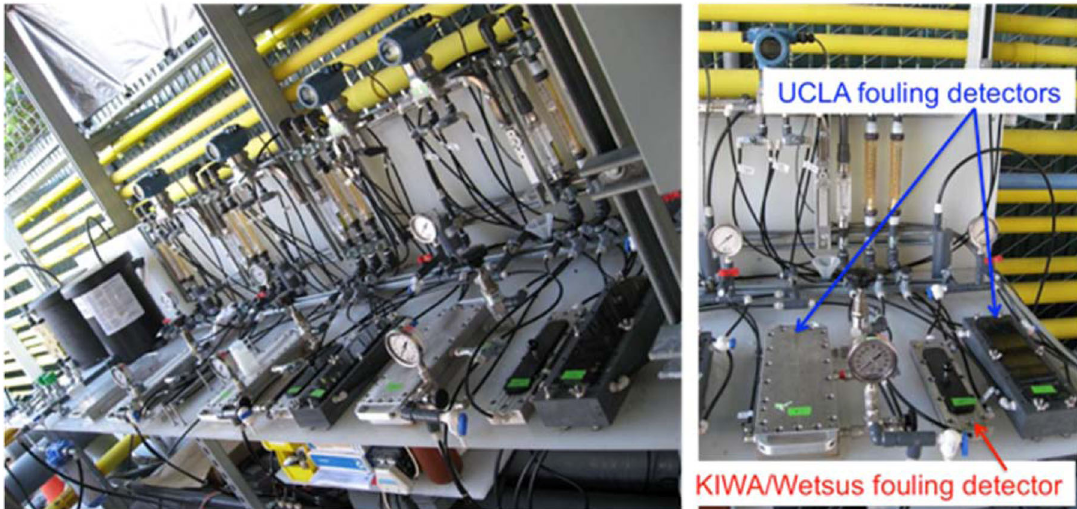
Fig. 11 Pictures of various fouling detectors employed at a seawater desalination plant. Research conducted at the Long Beach Water Department ’ s seawater RO/NF demonstration plant focusing on NF/RO membrane biofouling mechanisms, prevention, and monitoring. Tanuwidjaja 107 compared three different membrane fouling detectors to understand potential bias due to different monitoring device con fi gurations. At left, four parallel trains of 3 sensors per train are depicted. At right, a single train of 3 fouling detectors including UCLA ’ s high-pressure fouling detector, which enables fl ux, rejection and differential pressure to be monitored as well as a UCLA low-pressure fouling detector and a KIWA/Wetsus low-pressure fouling detector; both low-pressure fouling detectors monitor differential pressure only. Original image courtesy of Dian Tanuwidjaja. Copyright University of California, Los